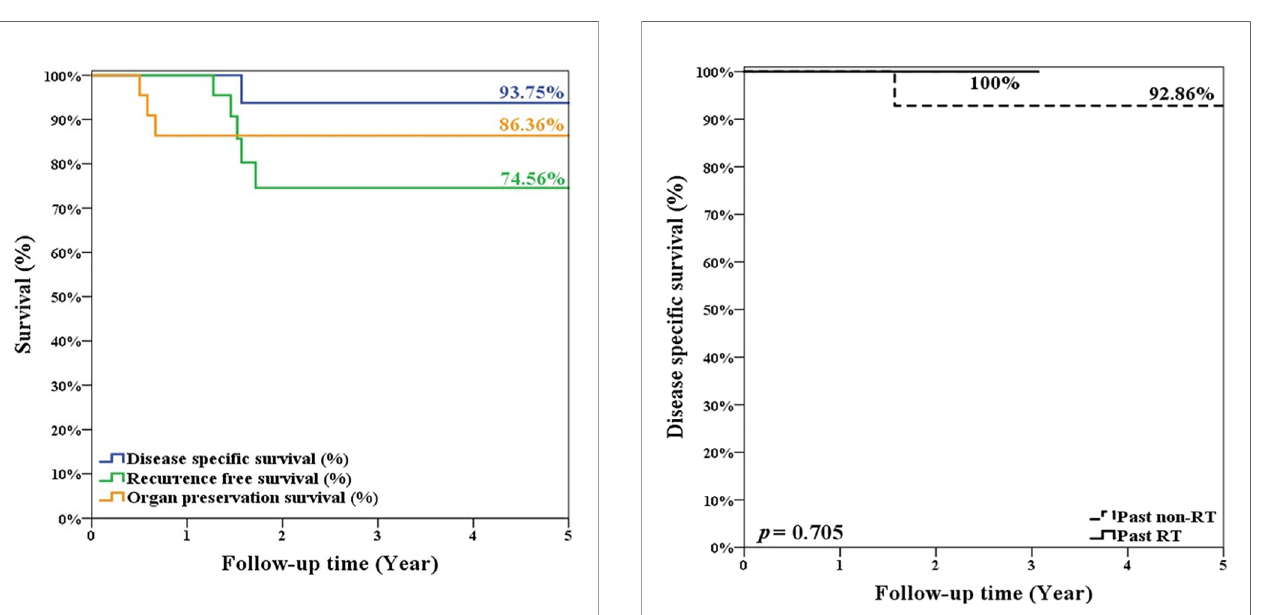
FIGURE 6 | The estimated 5-year overall survival rate and disease-speci fi c survival rate were 92.86% for patients without history of radiotherapy and were 100% for patients with history of radiotherapy. There was no signi fi cant difference (p = 0.705; log rank